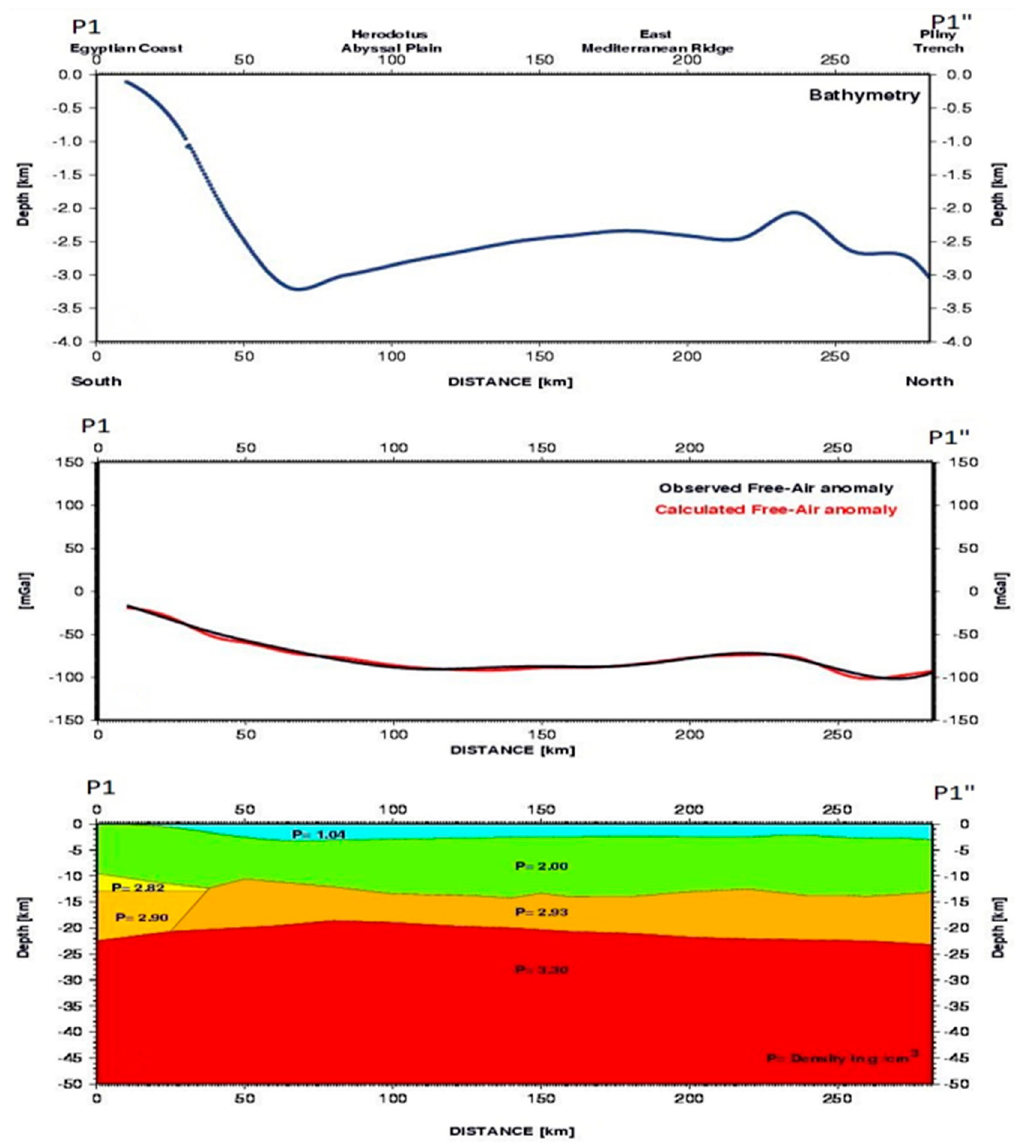
Figure 4. 2D modelling gravity along profile P1–P1 ″ .